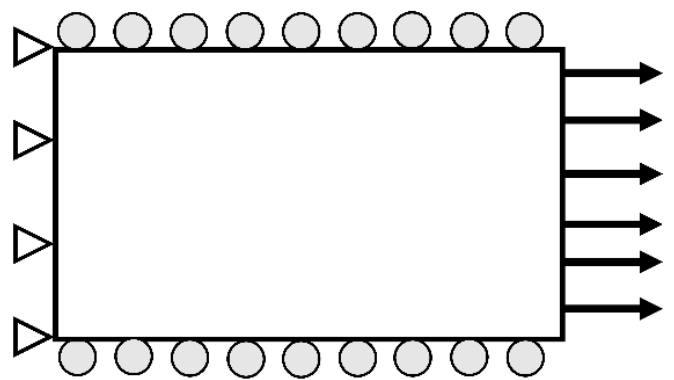
Figure 5. Schematic diagram of boundary conditions for the RVE.